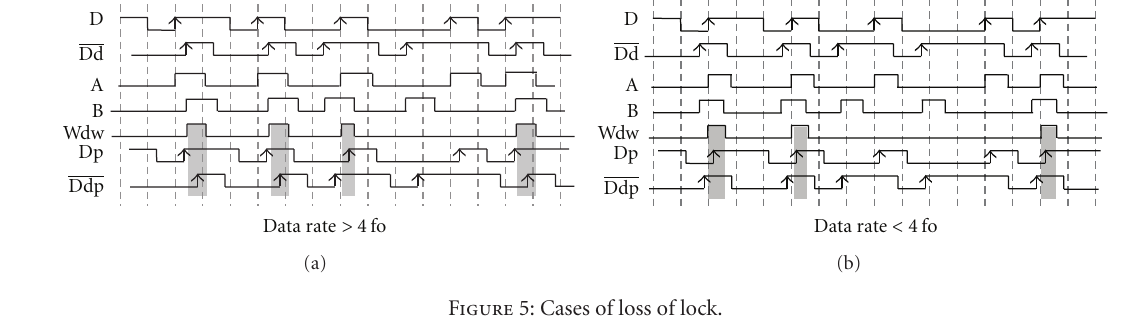
Figure 4: Fine delay tracking.